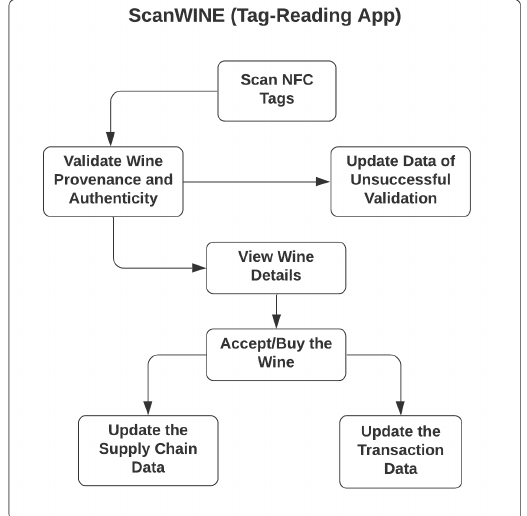
Figure 6. Use Case of Tag-Reading